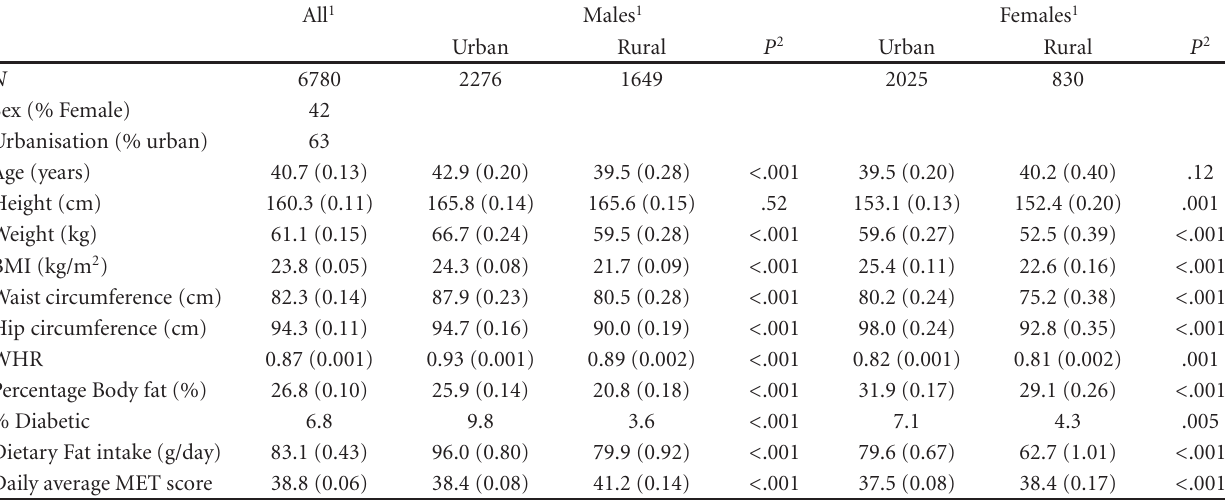
Table 1: Characteristics of the study population.